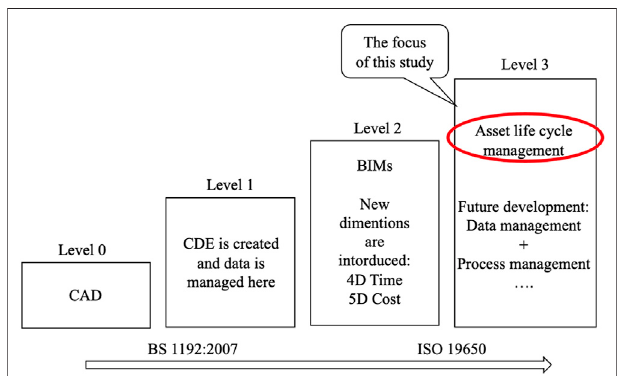
FIGURE 2 | BIM maturity levels (adopted from Bew and Richards (2008)).